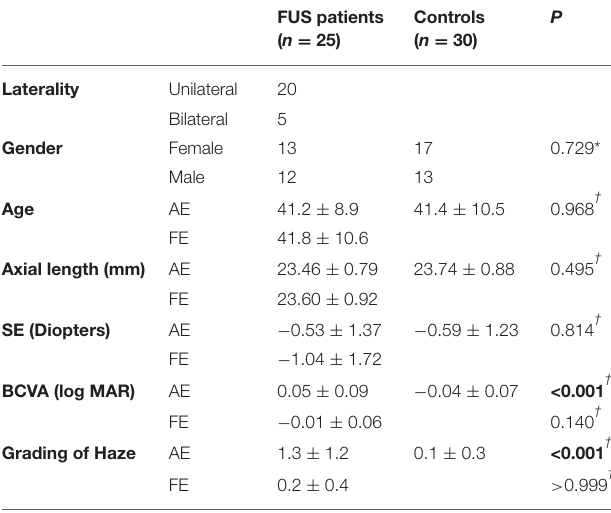
TABLE 1 | Demographic and clinical characteristics of study